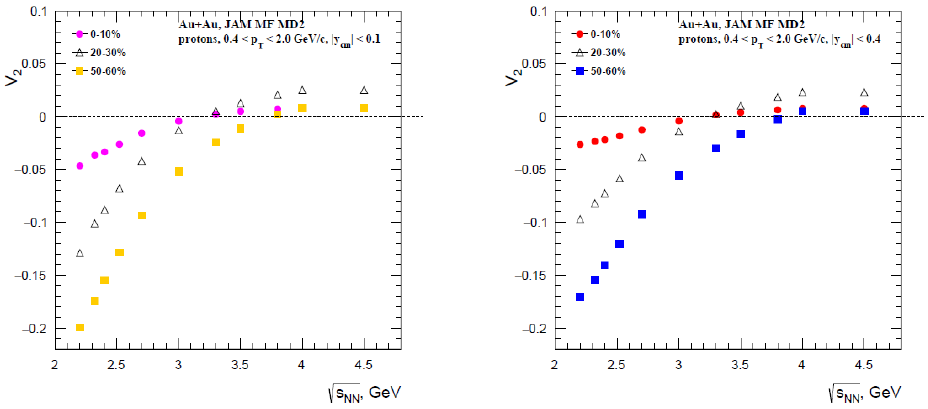
Figure 18. Collision energy dependence of v 2 of protons in the transverse momentum interval 0.4 < p T < 2.0 GeV/c and rapidity interval | y cm | < 0.1 ( left panel) and | y cm | < 0.4 ( right panel). Different symbols represent the intervals in collision centrality of Au + Au collisions, as indicated. The results for JAM model with hard momentum dependent mean-field MD2 ( K 0 = 380 MeV) EOS.